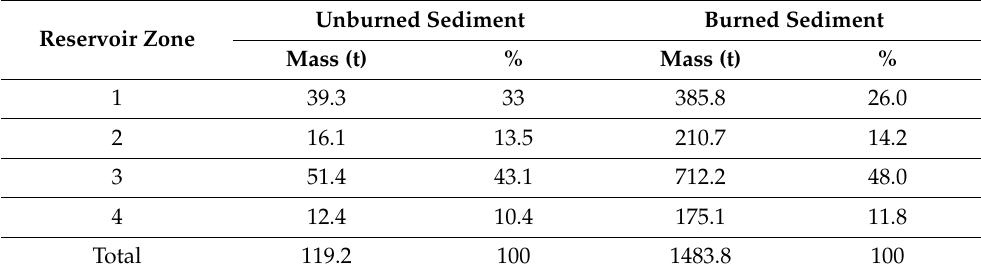
Table 7. Sediment mass deposited in the Oldman Reservoir from burned and unburned tributary inflows. Reservoir